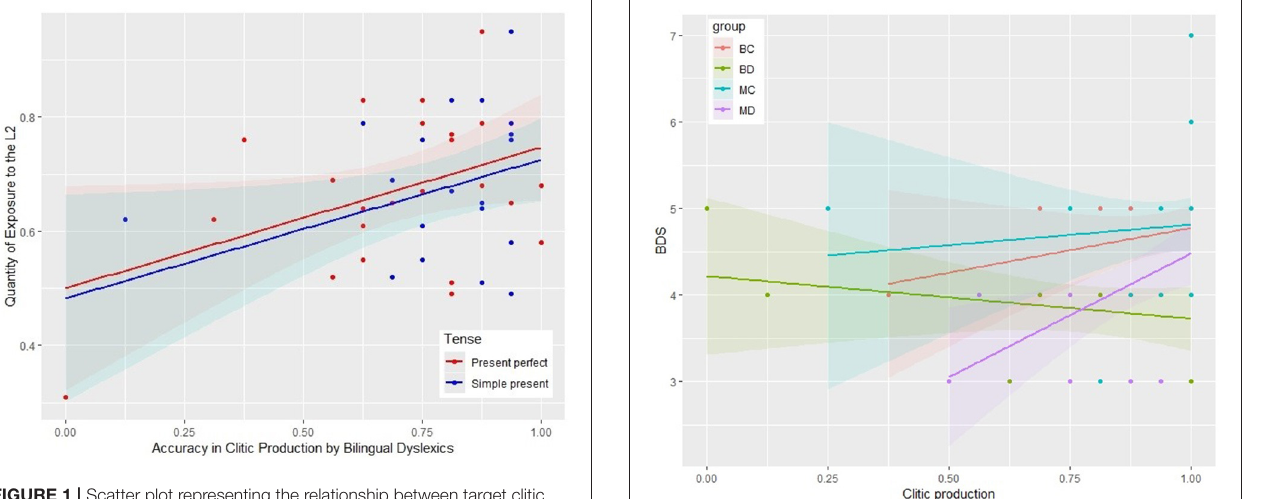
FIGURE 1 | Scatter plot representing the relationship between target clitic production in both the present and the present perfect, and QE (Quantity of Exposure to the L2) in bilingual dyslexics. TABLE 6 | Means (and SDs) of the results in the backward digit span tasks for each group. Monolingual dyslexics